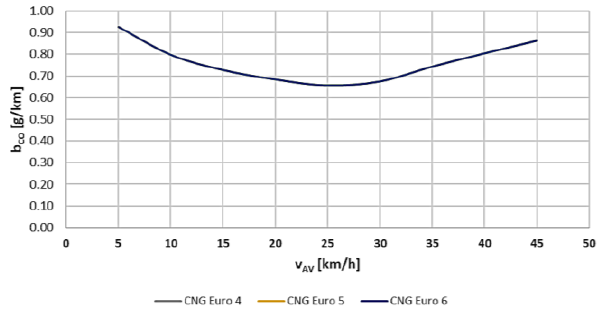
Fig. 32. CO emission from CNG PCs for Euro standards depending on average speed The figures show the dependence of CO emissions for various euro categories on the average speed. The cold start emission from PCs CNG as the same value for all Euro standards.